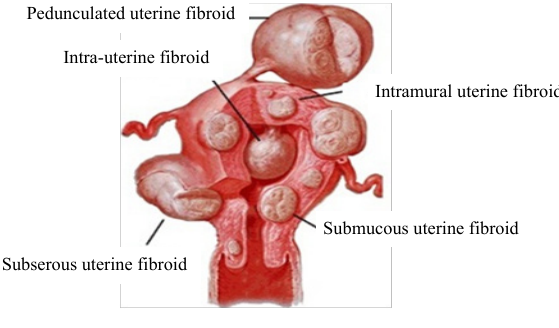
Figure 1. Uterine